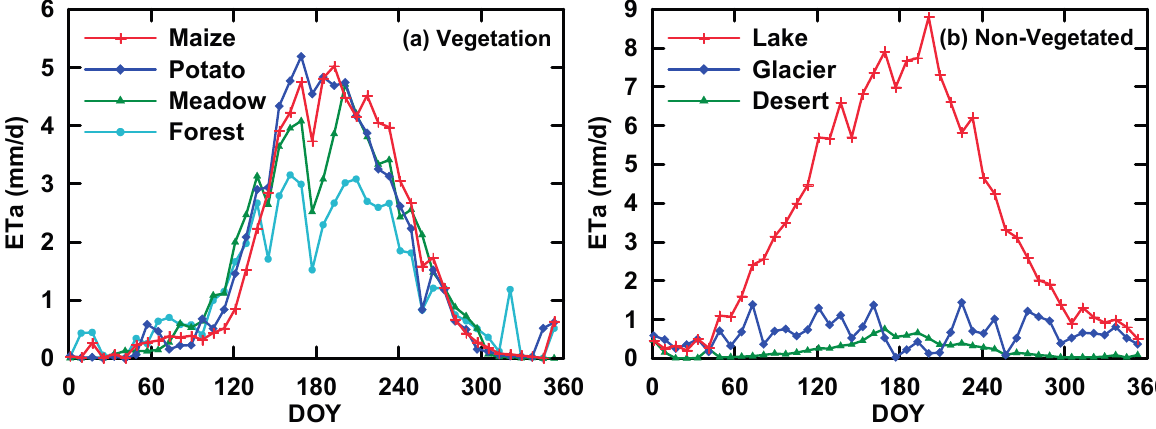
Figure 10. Seasonal variations of the ETa for ( a ) different vegetation types and ( b ) non-vegetated classes in 2010. Values shown are the eight-day means of ETa (mm/day).